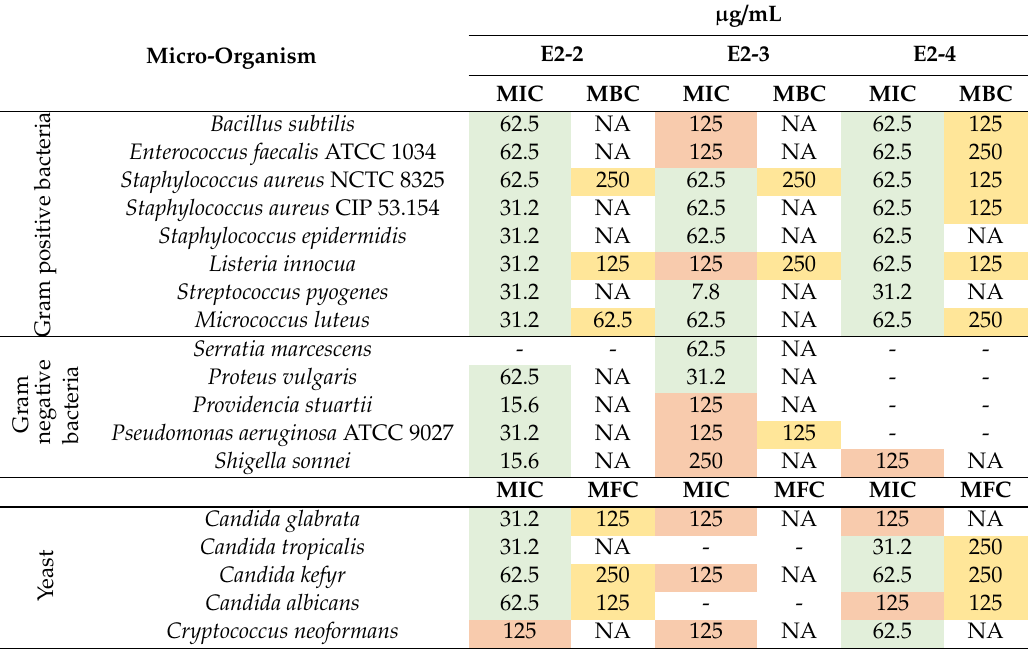
Table 3. MIC, minimum bactericidal (or fungicidal) concentration (MBC / MFC) values for the three best antimicrobial extracts, determined by microdilution assays. Tested concentrations ranged from 7.8 µ g / mL to 250 µ g / mL.